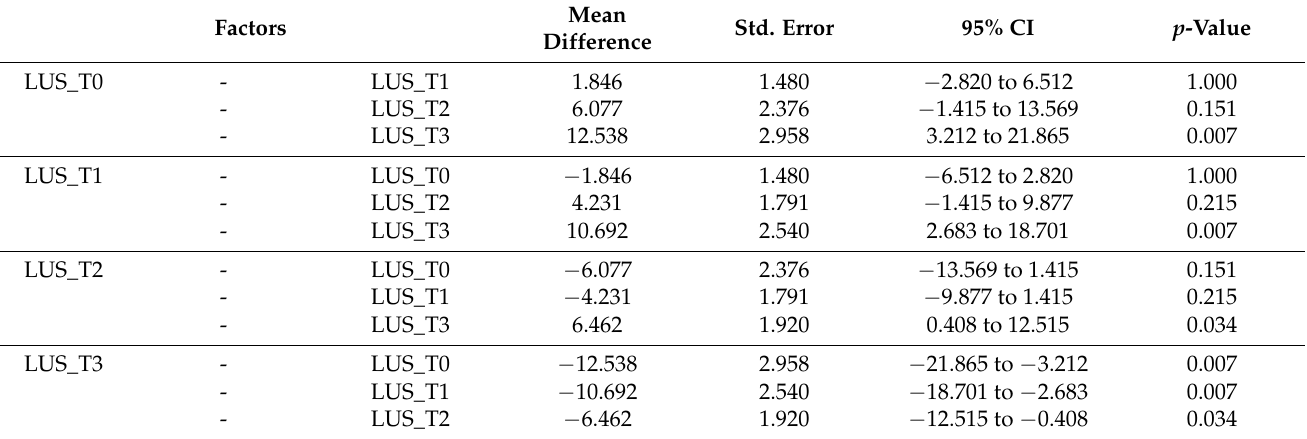
Table 2. Pairwise comparisons between CDH-LUS scores at different time points with a Bonferroni post hoc